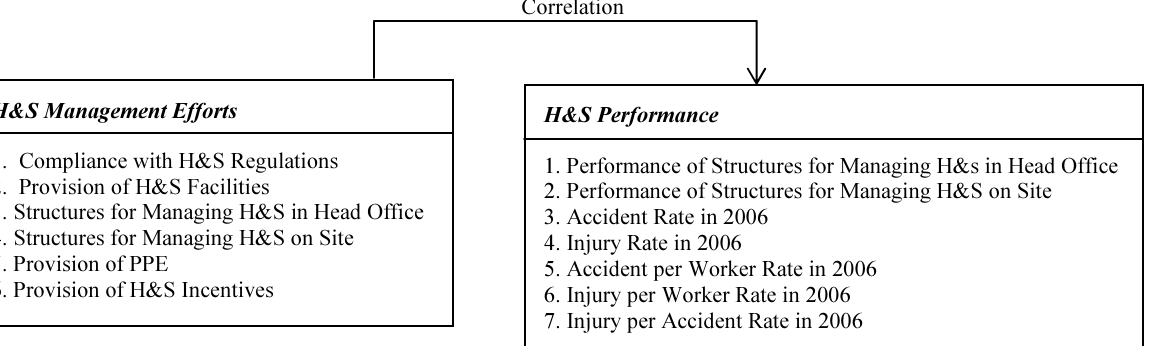
Fig. 1. A Conceptual Framework for comparing Health and Safety Management Efforts and Performance of Construction